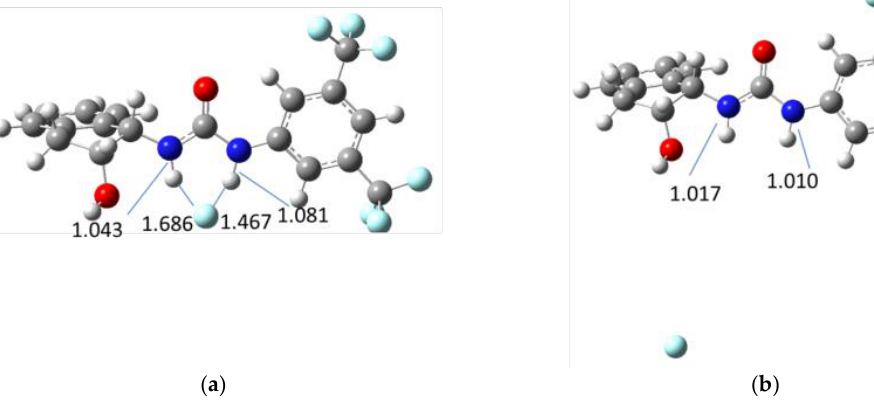
Figure 7. Geometries of sensor 1 fluoride bonded ( a ) and non-bonded fluoride ( b ).